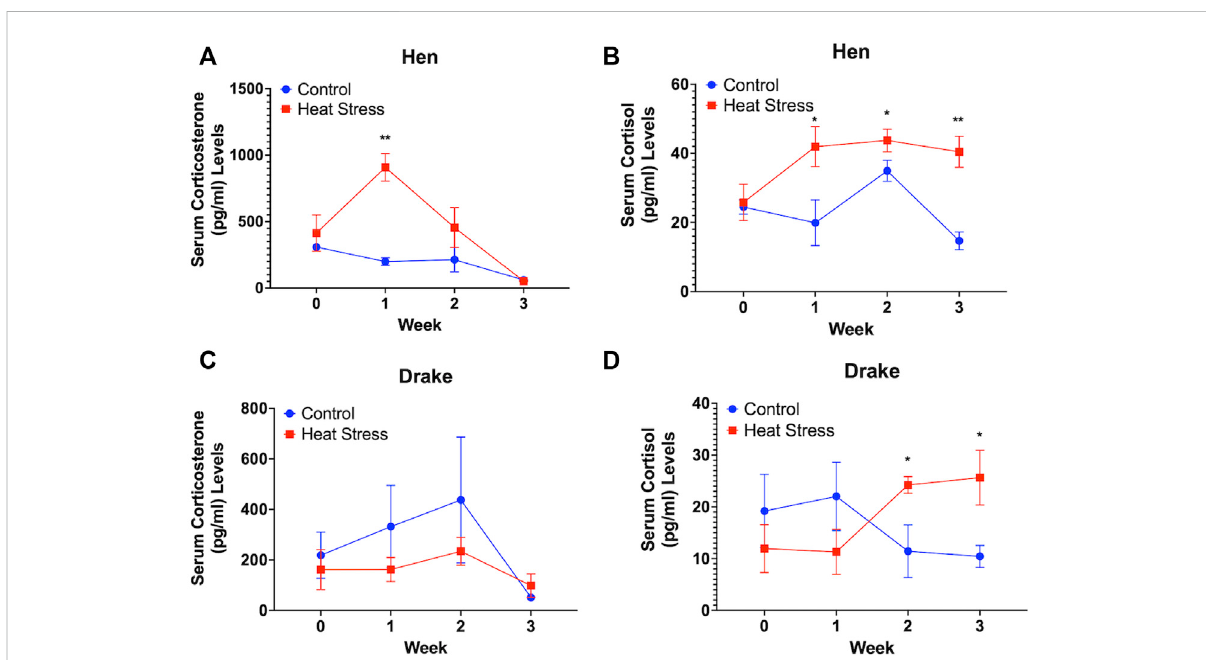
FIGURE 1 Serum corticosterone (A) and cortisol levels (B) in Hens and serum corticosterone (C) and cortisol (D) in Drakes exposed to cyclic heat stress (35 ° Cfor10h/dayand29.5 ° Cfortheremaining14h/day)orcontrol.Datashownaremeans±SEM, n =6/sex/treatment/week.Ducksexposedtoheat stressshowed asigni fi cantincrease inserum cortisollevels compared to controls atweeks 1,2, and 3forhens and weeks 2and3for drakes after the onset of treatment. Only hens exposed to heat stress showed a signi fi cant increase in serum corticosterone levels compared to controls at week 1 only after onset of treatment. * = p < 0.05, ** = p <